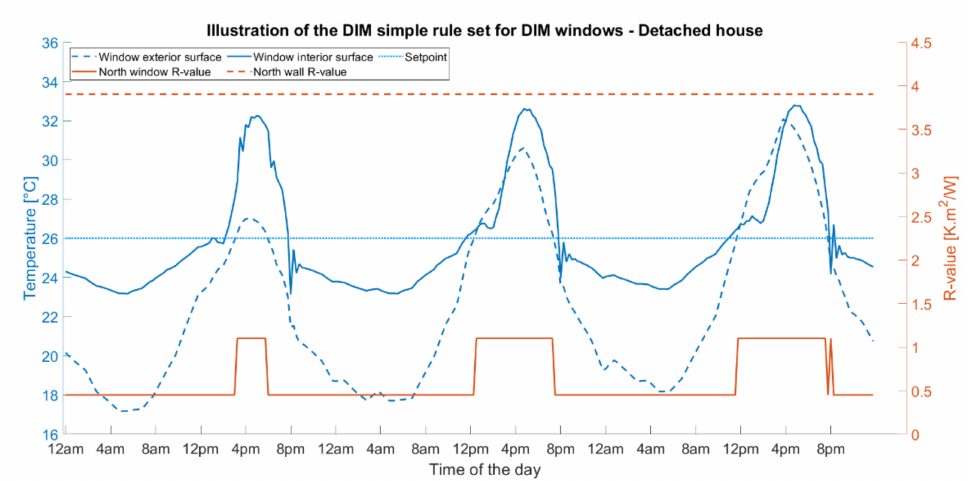
Figure 12. Performance of SIS windows only case during the period between 22 July to 24 July for the prototypical detached house located in Barcelona, Spain. For SIS windows, high R- value = 1.1 m 2 · K/W; low R-value = 0.45 m 2 · K/W; high SHGC = 0.4; low SHGC = 0.1. For static walls, R-value = 3.9 m 2 ·